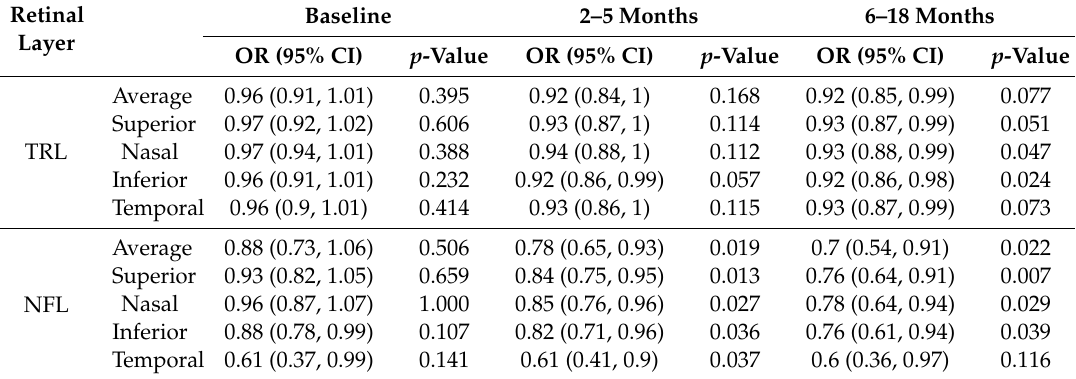
Table 6. Association between OCT parameters at each time point and worse visual field outcomes (MD values of − 10 dB or less) in ON